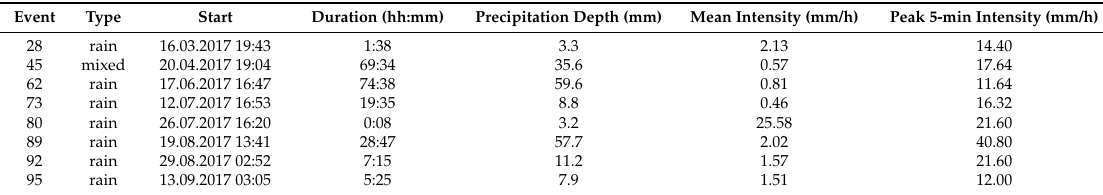
Table 2. Rainfall characteristics for the significant events.